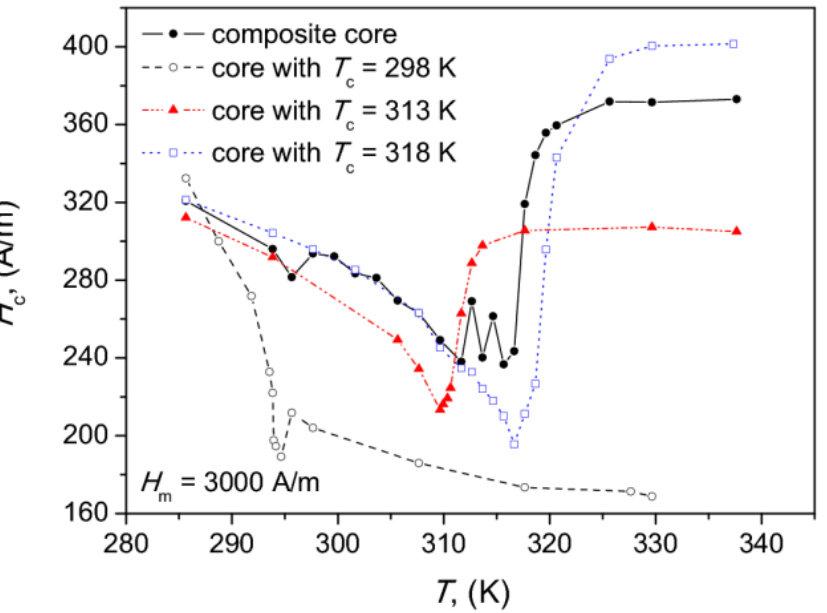
Figure 9. Coercive field strength vs. temperature for the composite core and the constituent cores, H m = 3 kA/m.